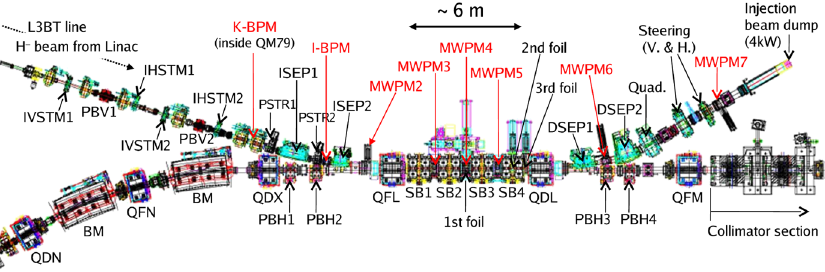
FIG. 2. (Color) Layout of RCS injection and successive H0 dump line. Four horizontal shift bump magnets ( SB1 (cid:3) 4 ) produce a constant closed orbit, while in addition, another four paint bump magnets ( PBH1 (cid:3) 4 ) in the horizontal direction and two vertical paint bump magnets ( PBV1 (cid:3) 2 ) in the vertical direction produce time dependent fields for the painting injection. The beam diagnostics system consists of a couple of BPMs (K-BPM, I-BPM) and several MWPMs (multiwire profile monitors) placed almost between the ( PBV1 (cid:3) 2 ). The first (PBV1) is a main painting magnet